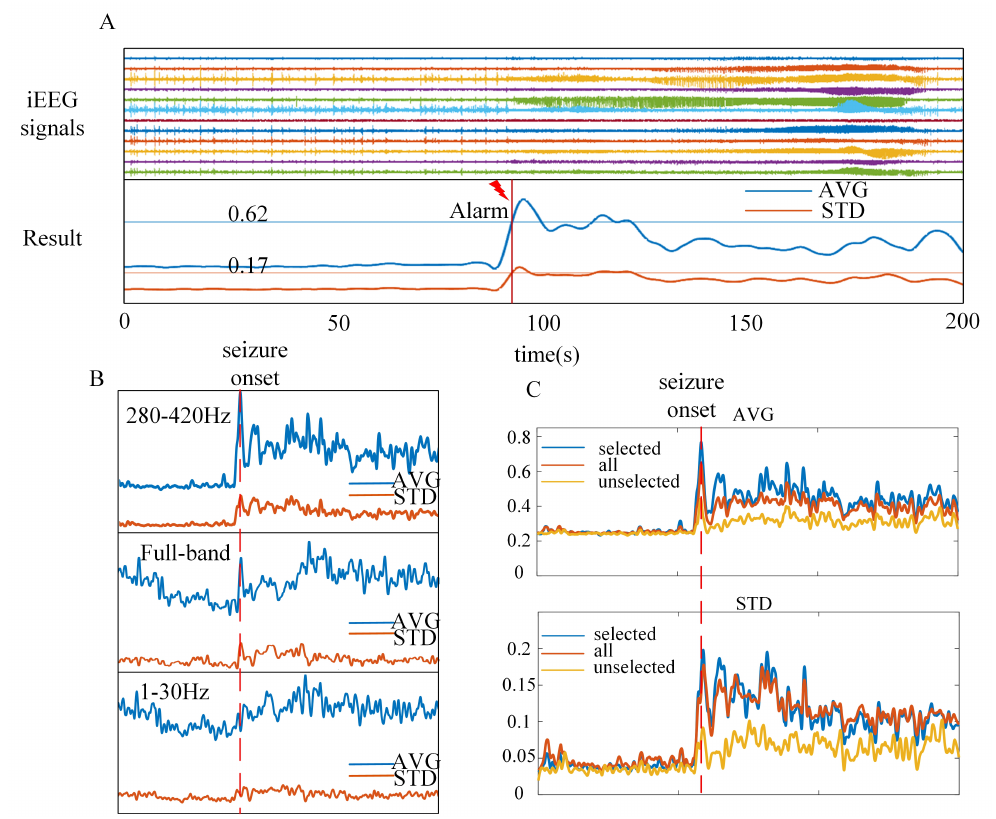
Figure 6. Examples of detection result and validity. ( A ) A typical example of detection results from Rat-1, the seizure onset can be detected by the thresholds. ( B ) The comparison of Rat-1 detection results in different frequency bands. ( C ) The comparison of Rat-1 detection results in different used channels.